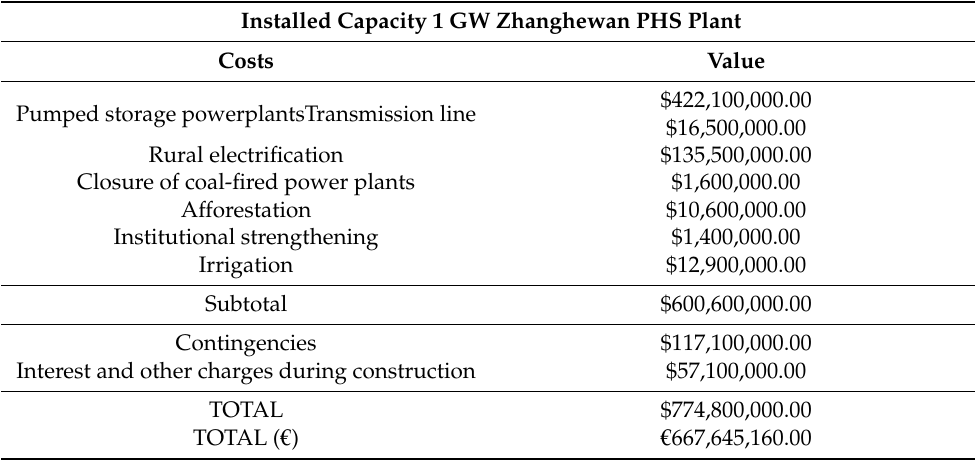
Table 1. Total cost for 1 GW capacity installed in a PHS plant (assuming Zhanghewan costs), assuming the average from 1 April 2017 to 12 June 2019 as the change value.